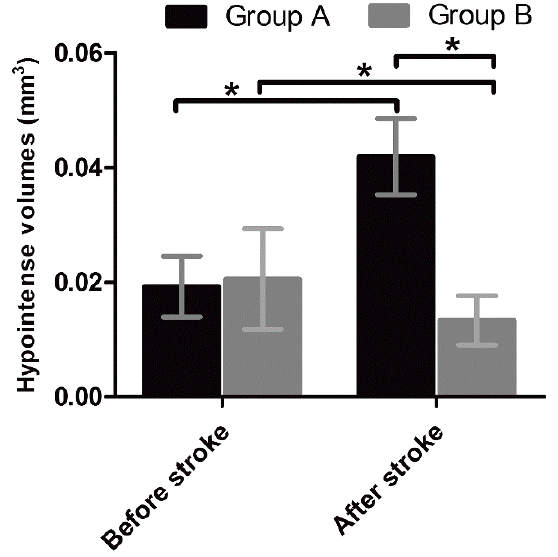
Figure 2 . Volumes of hypointense signals in the SVZ and RMS in pure stroke mice and stroke mice treated with Ara-C. Graphs show the volumes of hypointense signal measured in the SVZ and RMS on T2*-weighted MR images in pure stroke mice (group A) and stroke mice treated with Ara-C (group B) before induction of stroke and eight days after the stroke. * p < 0.05.